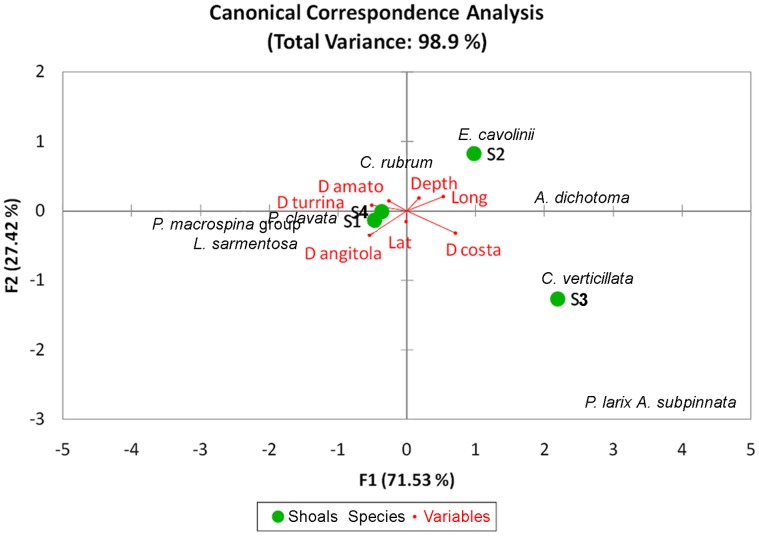
Results of the Canonical Correspondence Analysis.